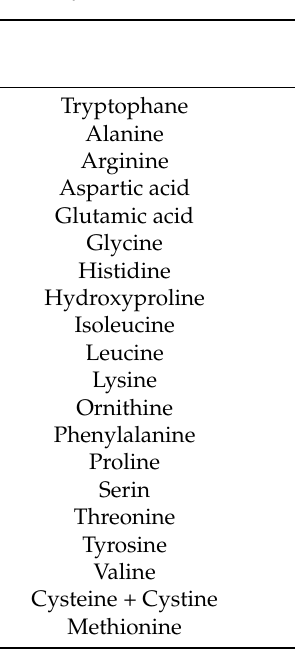
Table 1. The amino acid profile of initial substrate and cultivation residue after harvesting the second flush of oyster mushrooms.